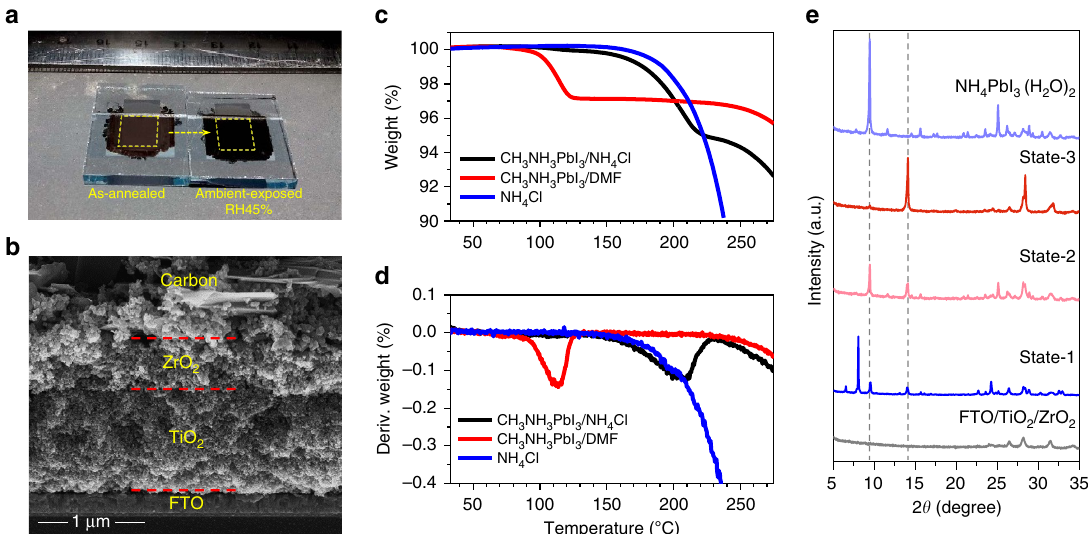
Figure 1 | Compositional and crystallographic characterization. ( a ) Digital images (from the glass side) of the as-annealed (crystallization step-1: 100 (cid:2) C for 10min) and ambient-exposed (crystallization step-2: relative humidity 45% for 36h) precursor-infiltrated triple-layer scaffold. The active area of the device is marked with a yellow rectangle. ( b ) Cross-sectional SEM image of perovskite-infiltrated TiO 2 /ZrO 2 /Carbon triple layer. The triple layer was deposited by screen-printing techniques, and the perovskite absorber was deposited using an NH 4 Cl-containing precursor solution and a moisture-induced crystallization process. ( c , d ) TGA results for the samples of CH 3 NH 3 PbI 3 /NH 4 Cl (red), CH 3 NH 3 PbI 3 /DMF (grey) and pure NH 4 Cl (blue). ( e ) X-ray diffraction patterns of the scaffold (FTO/TiO 2 /ZrO 2 ), precursor-infiltrated scaffold in state-1 (as-infiltrated), state-2 (solvent-evaporated) and state-3 (annealed), and NH 4 PbI 3 (H 2 O) 2 -infiltrated